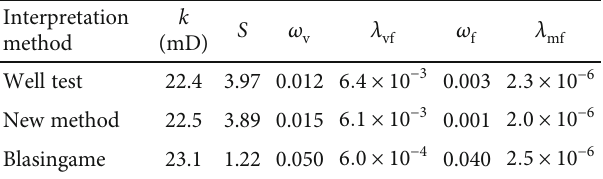
Table 5: Main interpreted parameters for validation case 2.